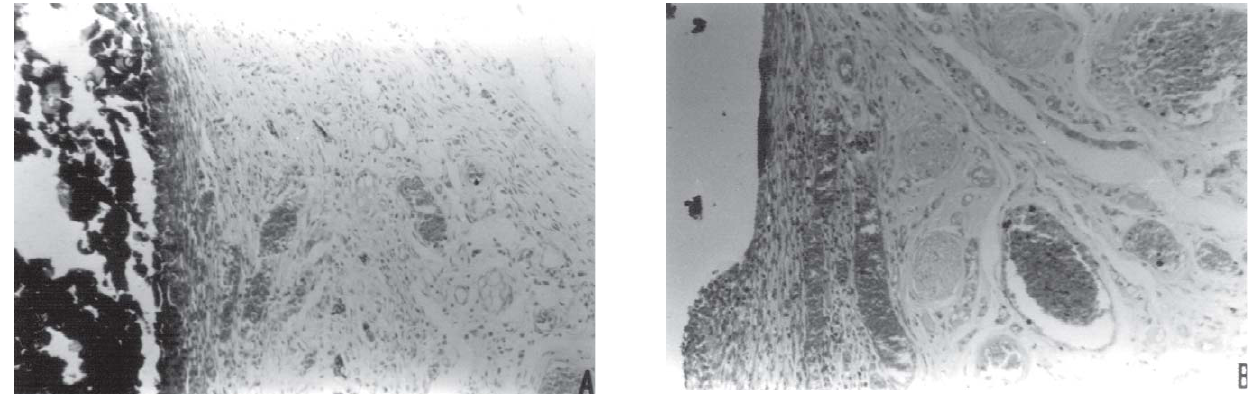
FIGURE 2- Response of the connective tissue in contact with Apexit cement (arrows): 14-day experimental period (A) and 90- day experimental period (B).